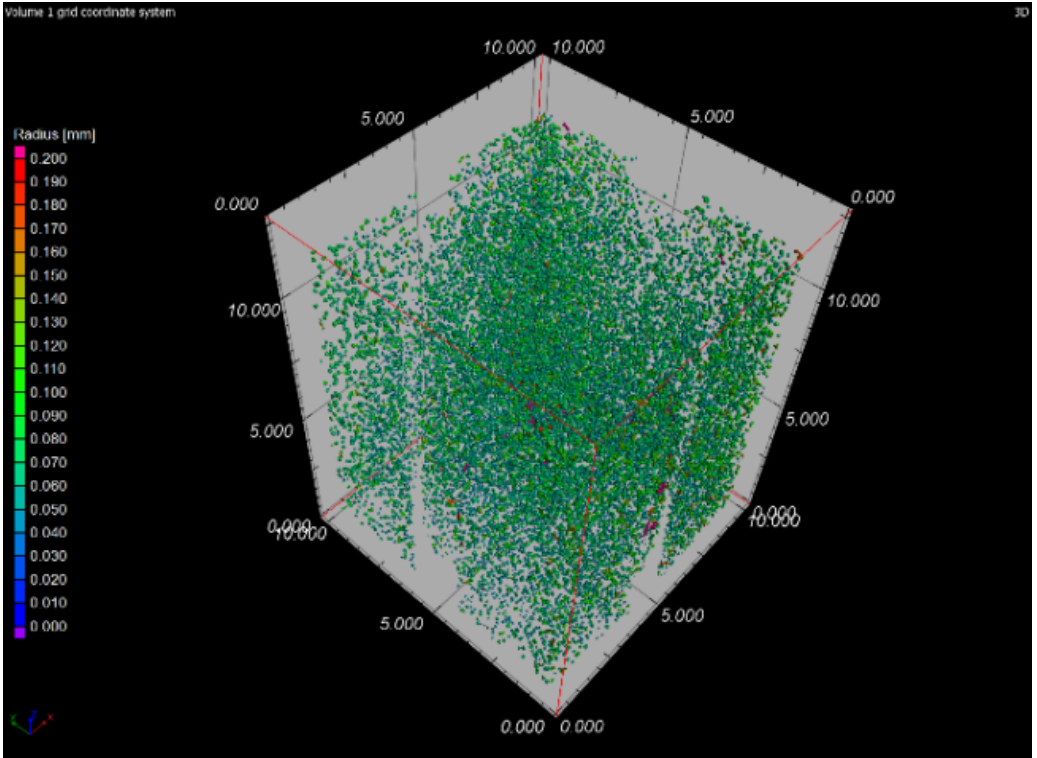
Figure 23. Example of detected pores in sample 5 after SLM. Materials 2020 , 13 , x FOR PEER REVIEW